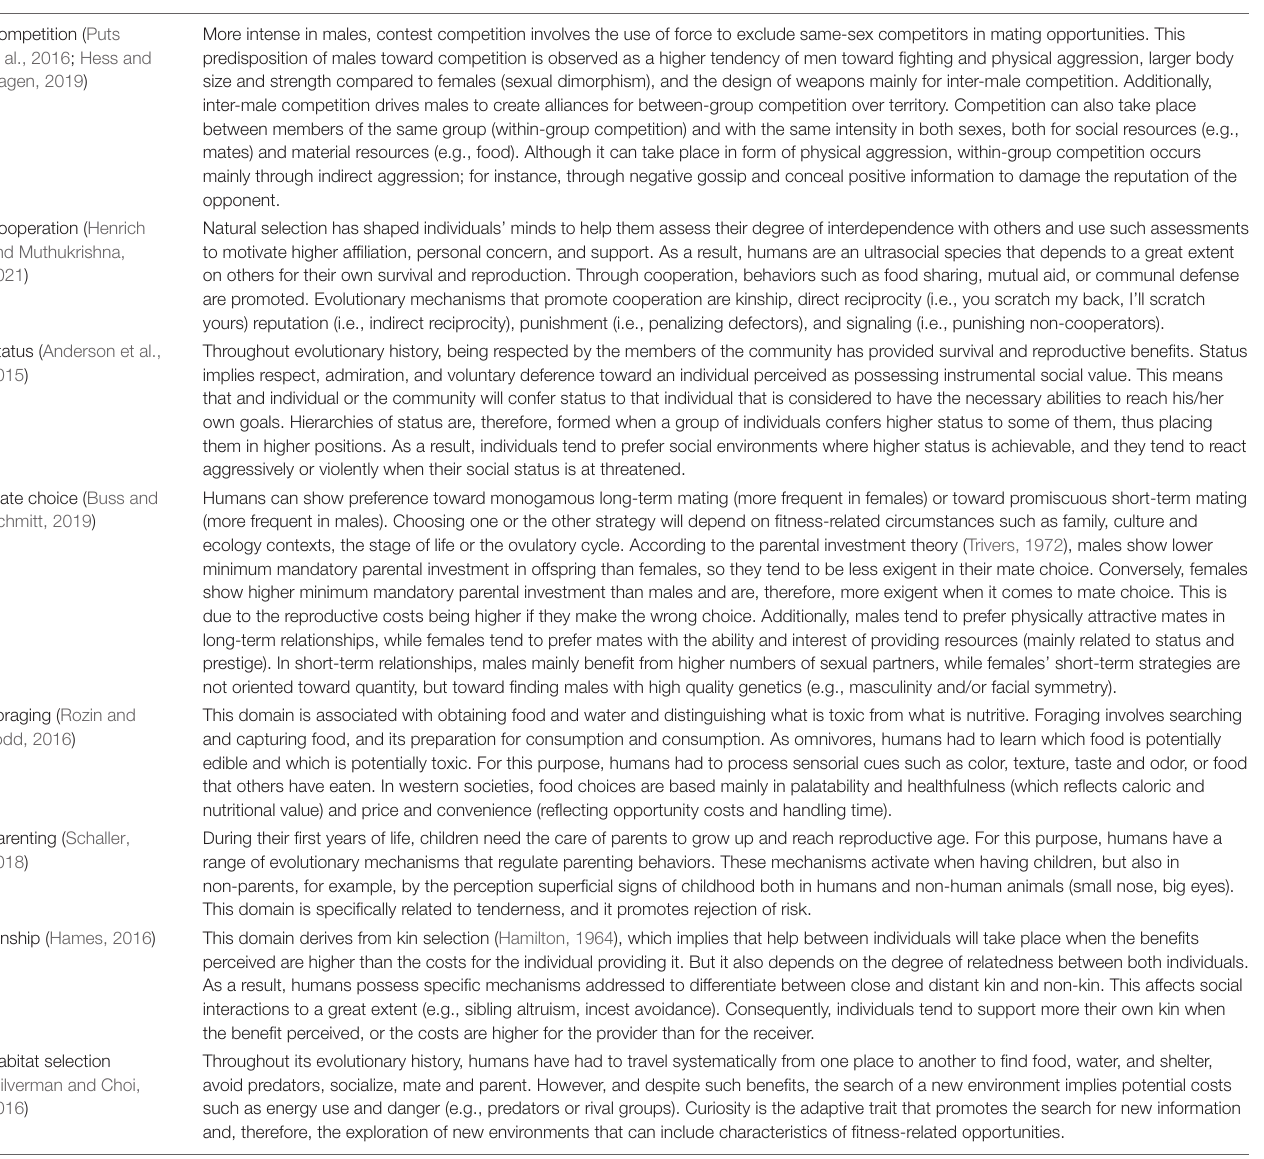
TABLE 1 | Evolutionary specific domains of